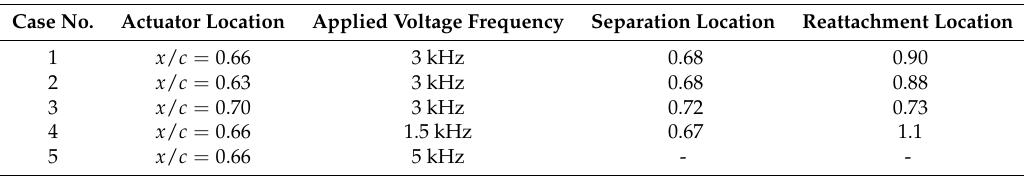
Table 4. Plasma actuator test case